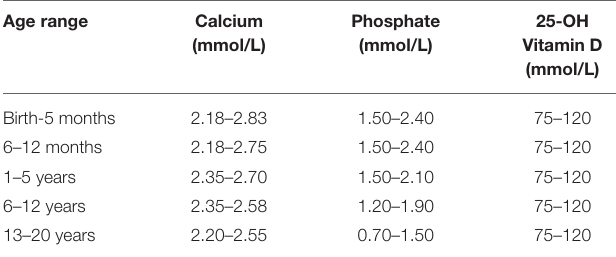
TABLE 4 | Reference values for phosphate, calcium and 25 OH vitamin D levels in children and adults (